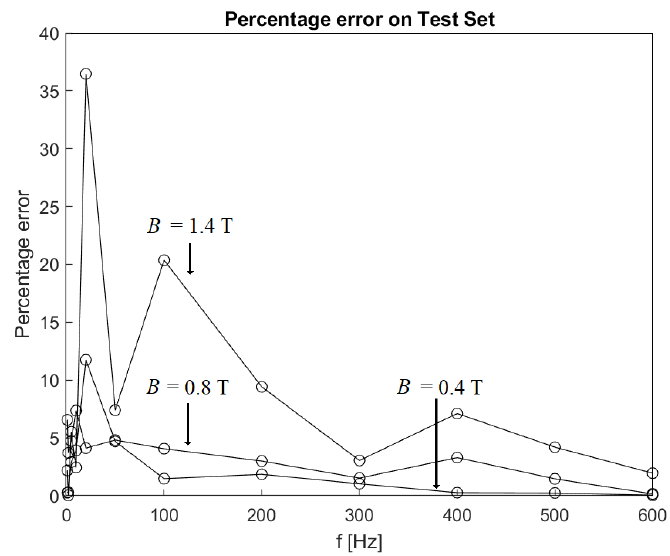
Figure 6. Percentage error related to the energy loss (Figure 5) on test set.